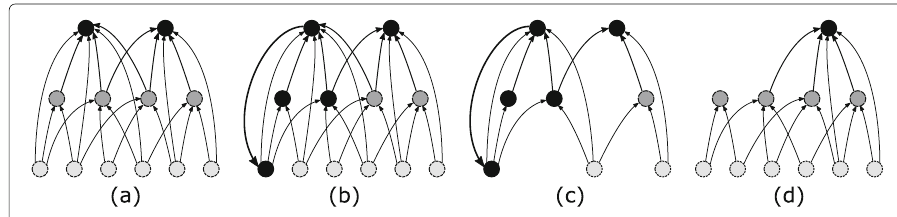
Fig. 2 Example graphs : Darker vertices have a higher importance (cp. “Preliminaries and problem” section)